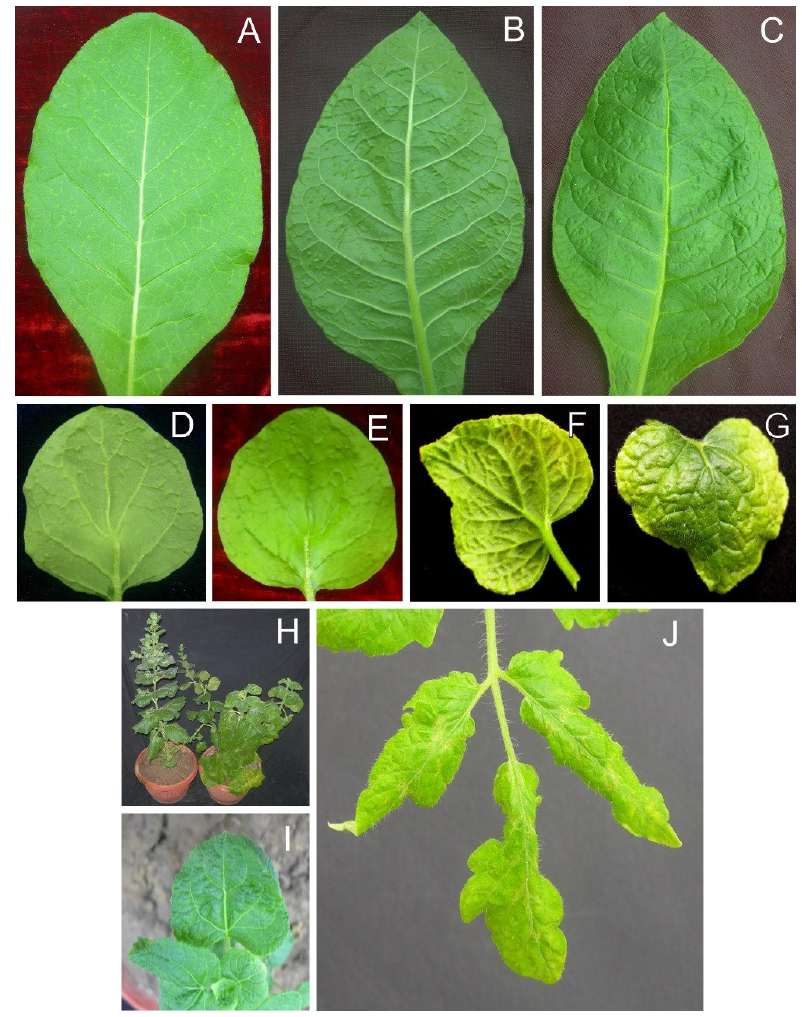
Figure 3. Symptoms of plants infected with AEV and AYLCB clones obtained from isolate SOL. Nicotiana tabacum plants infected with AEV SOL /AYLCB SOL initially (15 dpi) showed mild vein yellowing on leaves developing subsequent to inoculation ( A ) which developed into what looked, on the underside of the leaf, like vein swelling ( B ) but on the upper leaf surface was evidently depression of the veins ( C ) at 20 dpi. Infected N. benthamiana initially (12 dpi) exhibited enations on the veins on the undersides of leaves ( D ) that on the upper leaf surface were seen to be depressions (dimples; E ). In older N. benthamiana infections (30 dpi) leaves showed extensive chlorosis with raised veins on the lower surface ( F ) and sunken veins on the upper surface ( G ) giving a crumpled appearance. A comparison of a healthy, non-inoculated N. benthamiana plant (left) and an AEV SOL /AYLCB SOL infected plant at 30 dpi is shown in panel ( H) . The infected plant showed some chlorosis and overall downward curved leaves. The height of the plant was not greatly affected. Ageratum conyzoides plants infected with AEV SOL /AYLCB S ° L showed mild leaf crumpling but no vein yellowing ( I ). Infected Solanum lycopersicon plants showed chlorosis of leaves developing after inoculation and vein necrosis ( J